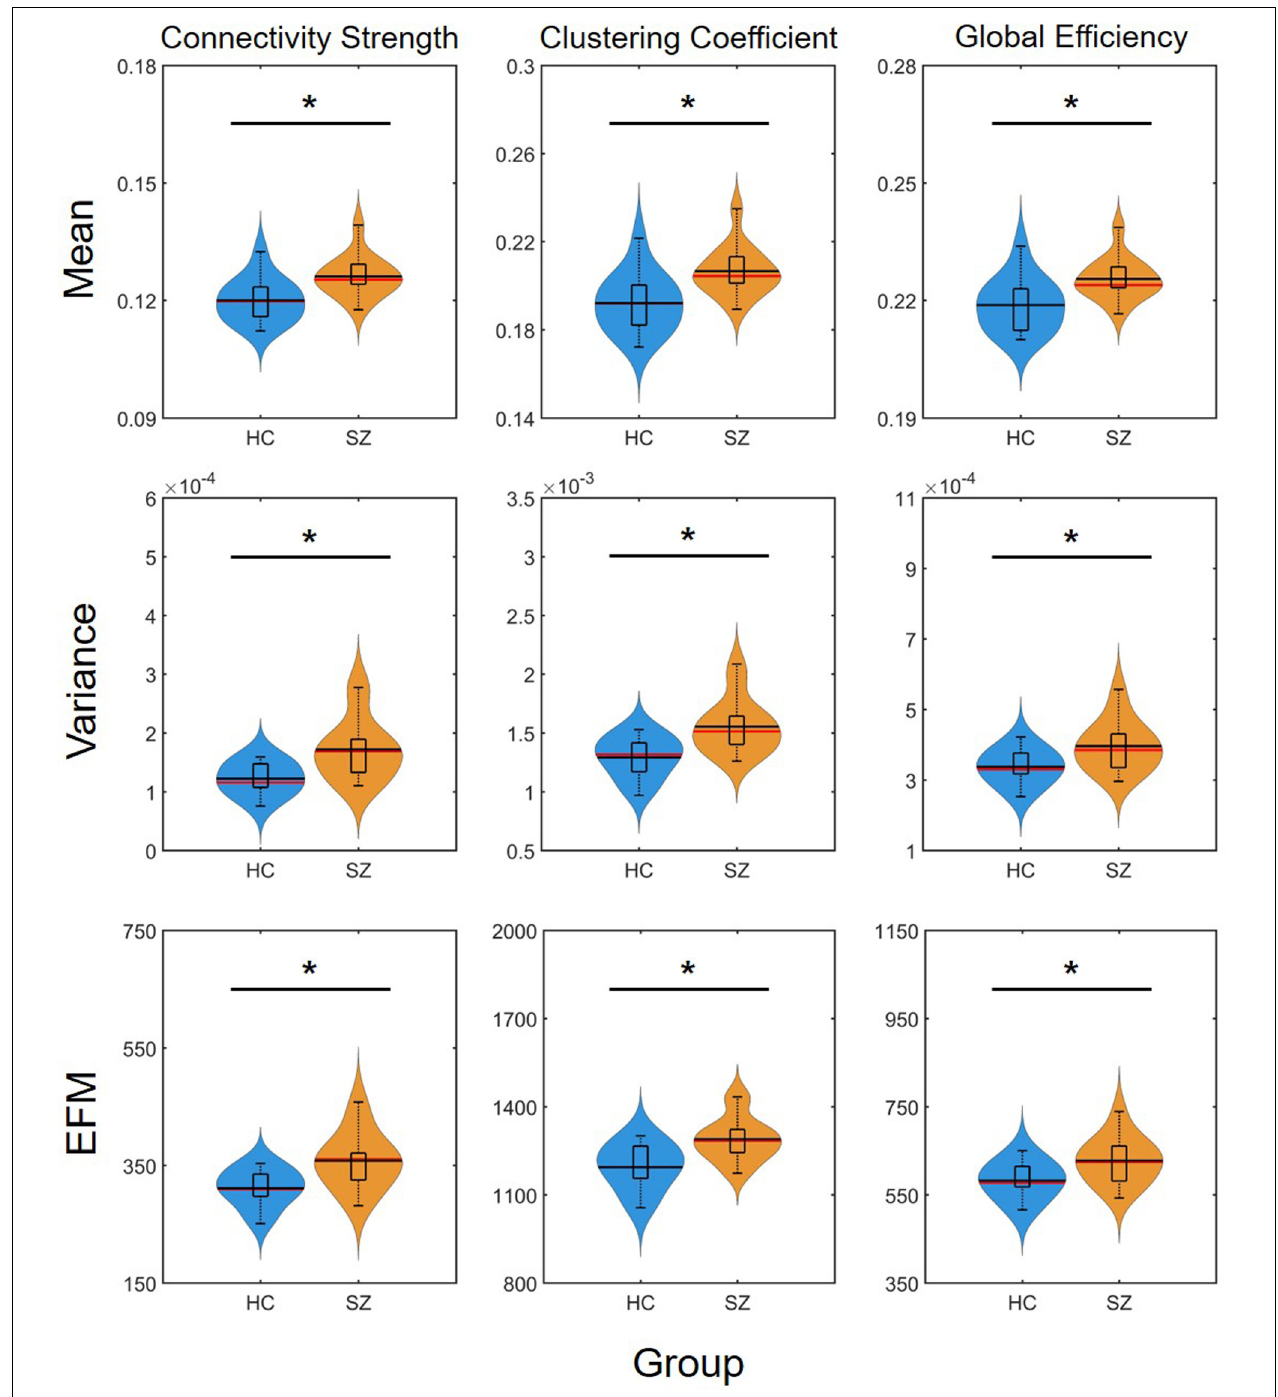
FIGURE 5 | Results of the area-under-the-curve analysis regarding the mean, variance and excursions from median (EFM) of dynamic network measures. Higher mean and temporal variability of dynamic functional connectivity in SZ is apparent as captured in both connectivity strength, clustering coefficient and global efficiency. Asterisk marks significant group difference ( p < 0.05) identified with two-sample t -test. HC, healthy control; SZ, schizophrenia.